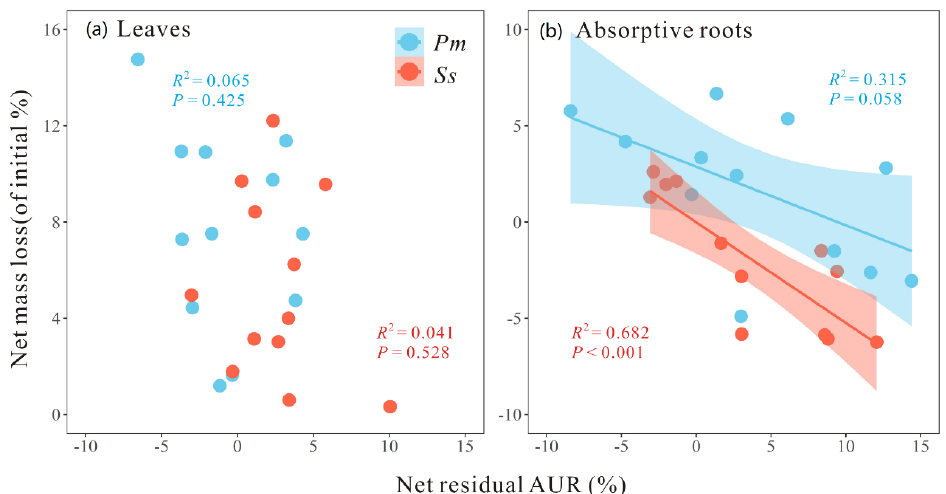
Figure 6. Relationships between the net residual AUR concentration and net mass loss for decomposing leaves and absorptive roots in the 3-year stage of decomposition. ‘Net values’ were calculated by deducting the residual AUR concentration or mass loss of the control treatment from that of the nutrient-addition treatments. Different nutrient treatments were pooled, n = 12, p < 0.05. AUR, acid-unhydrolysable residue